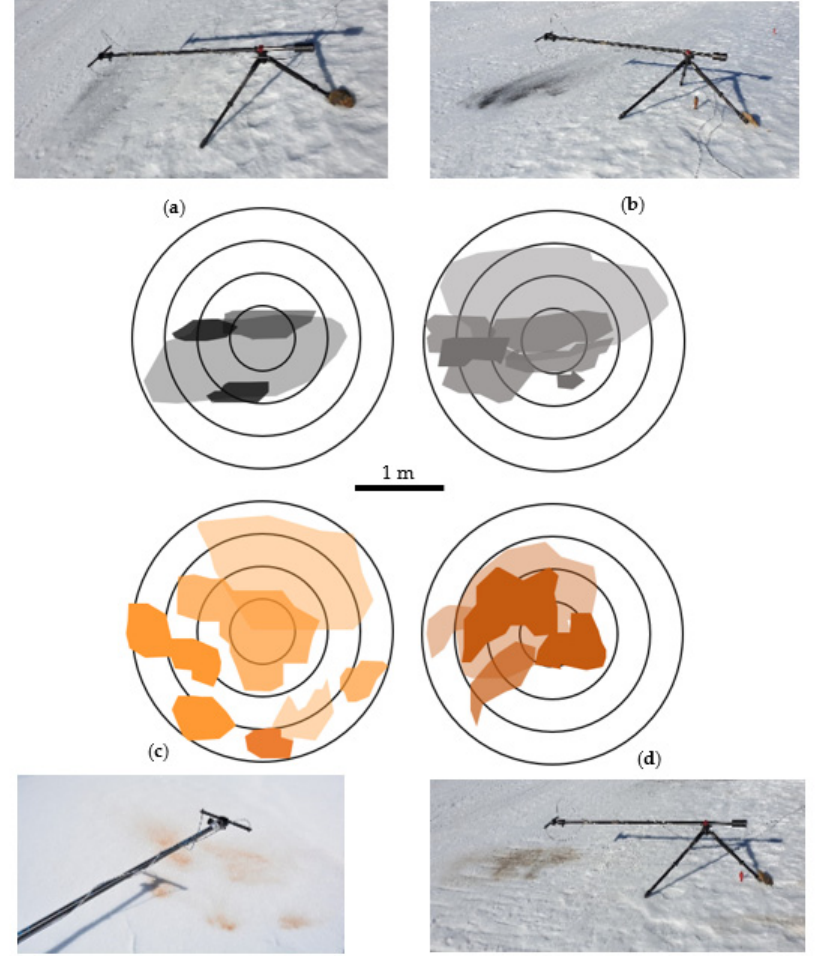
Figure 5. Weighing method and example for ( a ) soot, ( b ) ash, ( c ) haze, and ( d ) sand. Concentric circles represent radially weighted areas. Three levels of darkness are also shown for each material, considering different concentrations.